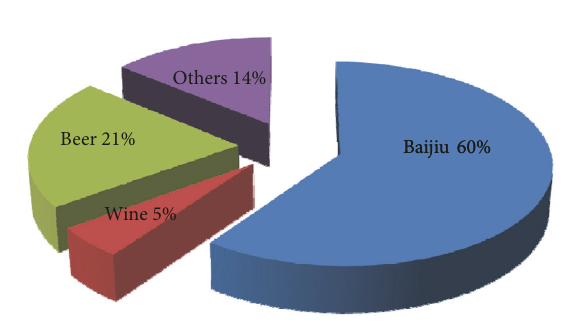
Figure 1: Structure of alcoholic beverages in 2013